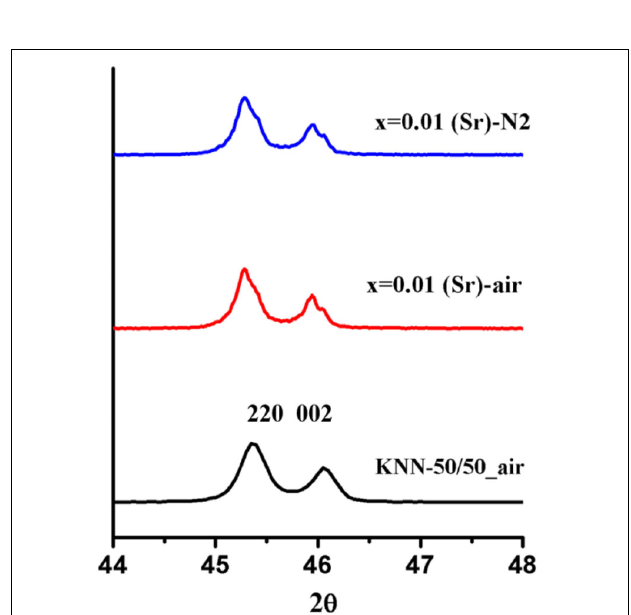
FIGURE 4 | Zoomed peak at 2 θ ∼ 45–46, in comparision with the peak shape of 1% Sr_air/N 2 with